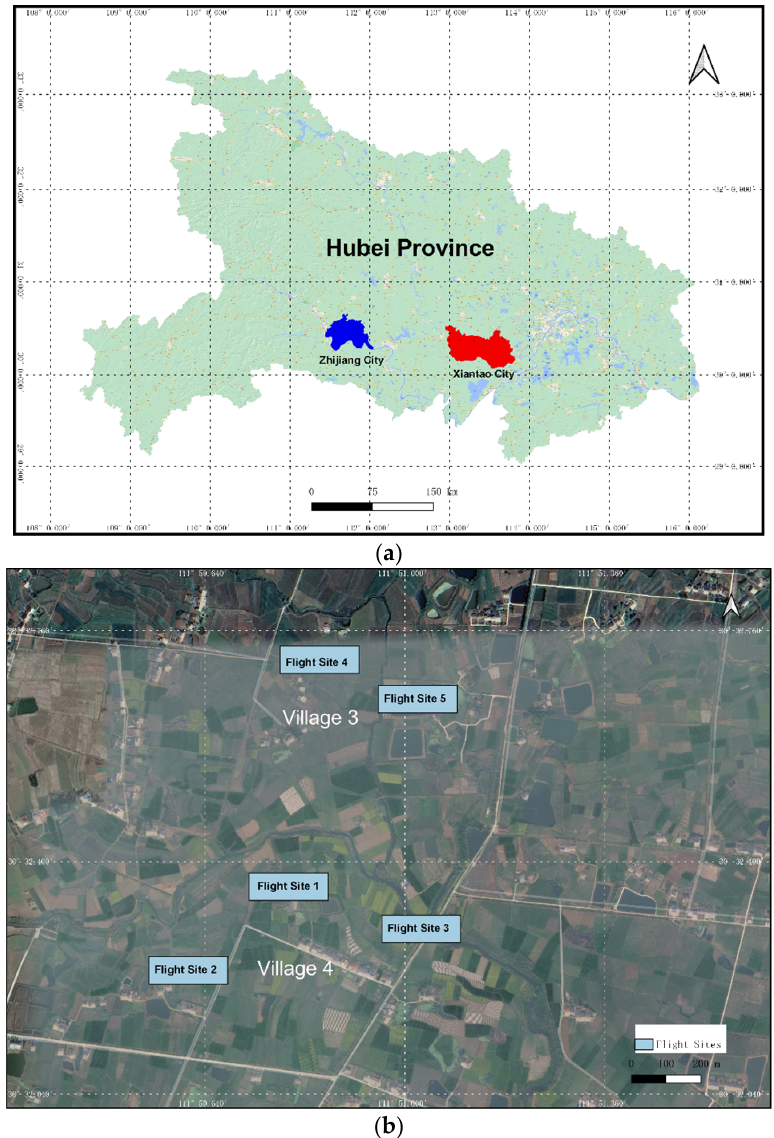
Figure 1. The selected Hubei province for middle-season rice in China. ( a ) The two selected cities in Hubei; the left city is Zhijiang and the right city is Xiantao; ( b ) the selected villages 3 and 4 in Zhijiang